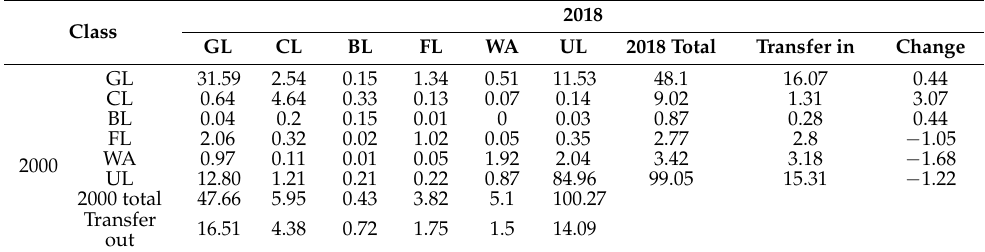
Table 4. The transfer matrix of land-use changes from 2000 to 2018 (unit: 10 4 km 2